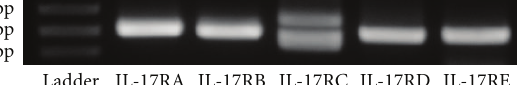
Figure 1: The expression of IL-17 receptors in synovial fibroblasts. IL-17RA, IL-17RB, IL-17RC, IL-17RD, and IL-17RE mRNA levels in synovial fibroblasts were analyzed using real-time PCR. The PCR products were electrophoresed through an agarose gel.